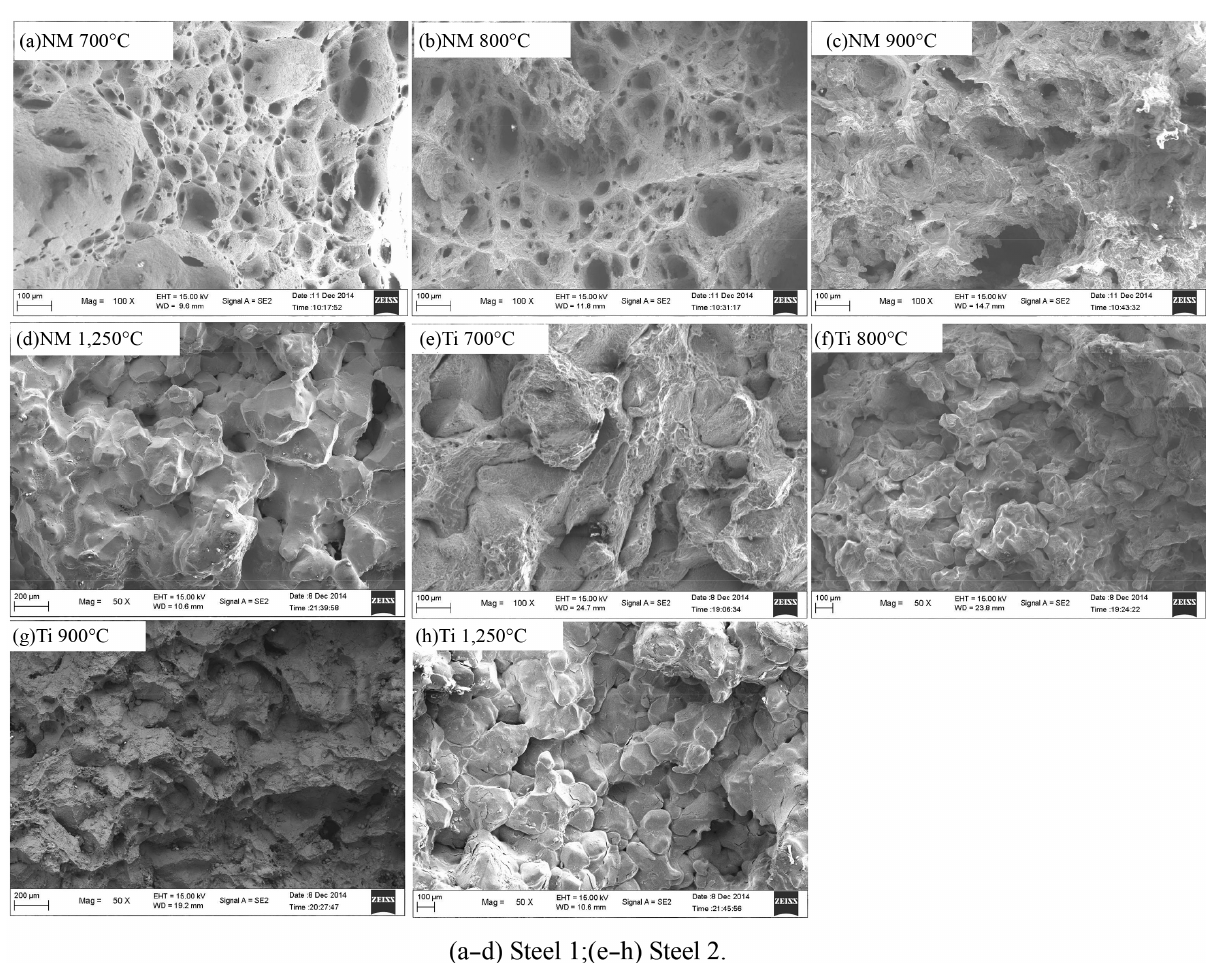
Figure 5: SEM images from the fracture